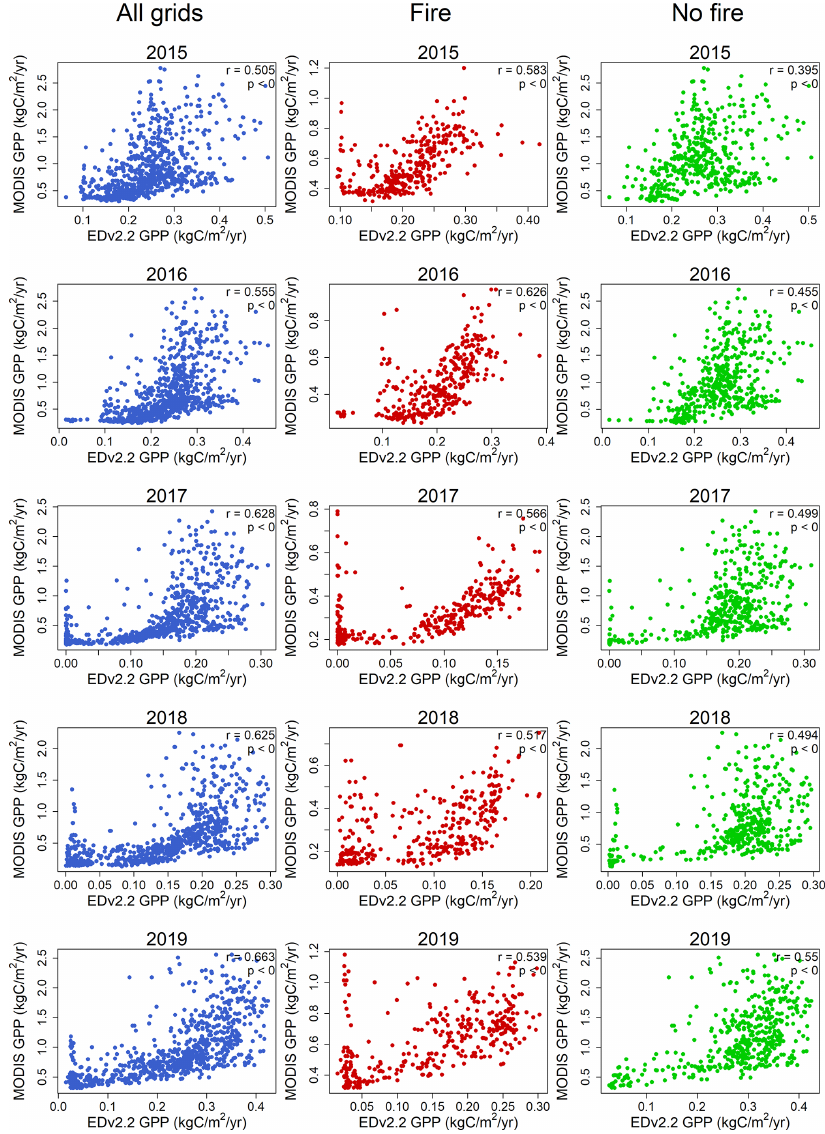
Figure A3. Correlation plots between mean monthly GPP (kgCm − 2 yr − 1 ) values derived from EDv2.2 and MODIS for July of every pre-fire (2015) and post-fire (2016–2019) years, categorized by overall, burned, and unburned grids.